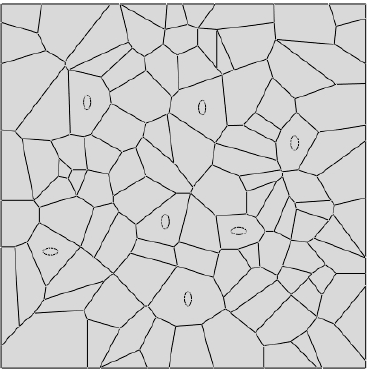
Figure 8. Inclusions distribution on the polycrystalline model components.